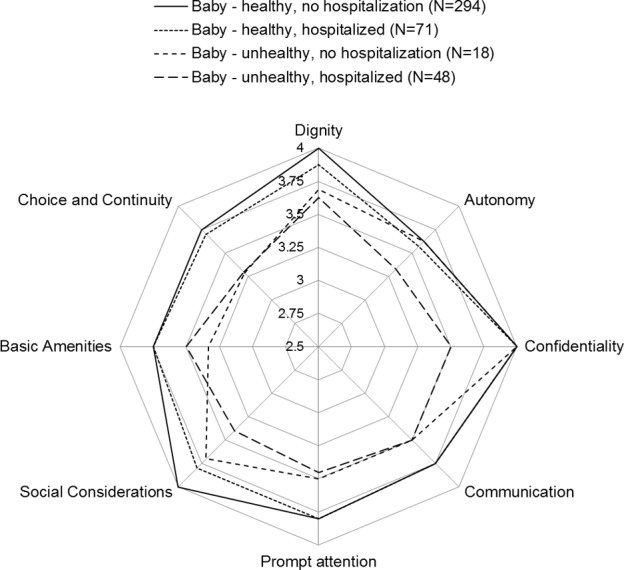
Discriminative validity: median domain-specific ReproQ-score according to perceived neonatal outcome and neonatal hospital admission.The figure shows the median domain-specific ReproQ score for 4 groups: 1) women who did not perceive health problems with their baby and whose baby was not hospital-admitted (MD = 3.78, IQR = 3.52–3.87); 2) women who did not perceive health problems with their baby, but whose baby was hospital-admitted [e.g. for monitoring] (MD = 3.72, IQR = 3.45–3.85); 3) women who perceived health problems with their baby, but the baby was not hospital-admitted (MD = 3.47, IQR = 3.16–3.80); and 4) women who perceived health problems with their baby and whose baby was hospitalized (MD = 3.42, IQR = 3.10–3,72) (p>0.001). Note that the client's perception of neonatal outcome may differ from clinical judgement; here we assume the client's perspective to be primarily important.